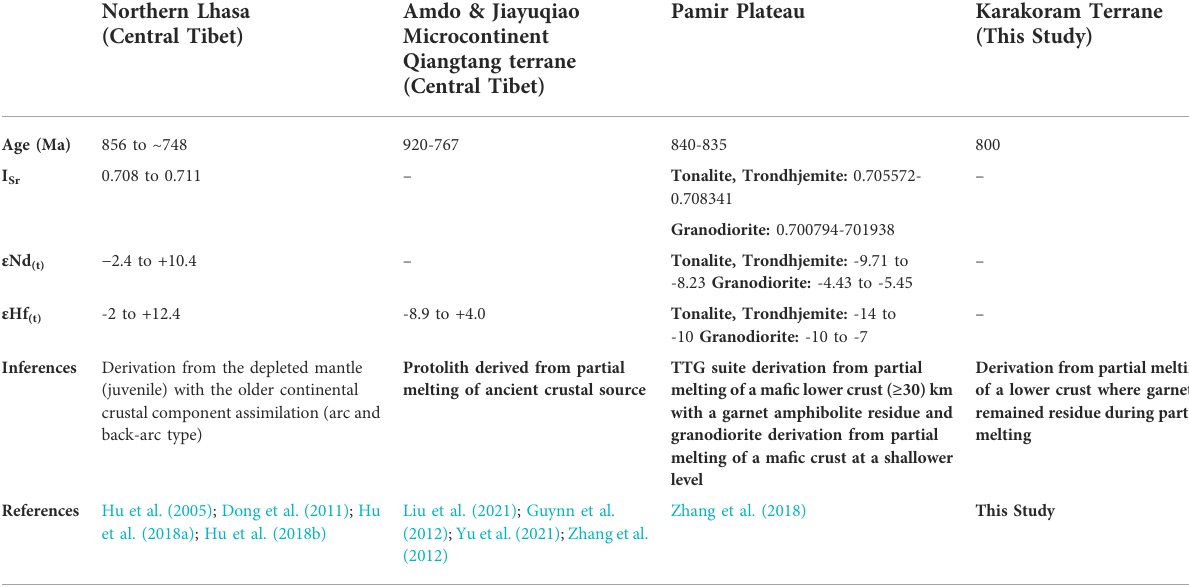
TABLE 2 Compiled Sr-Nd and ε Hf (i) isotope data from Early-Neoproterozoic magmatic rocks from Northern Lhasa, Qiangtang terrane, Pamir and